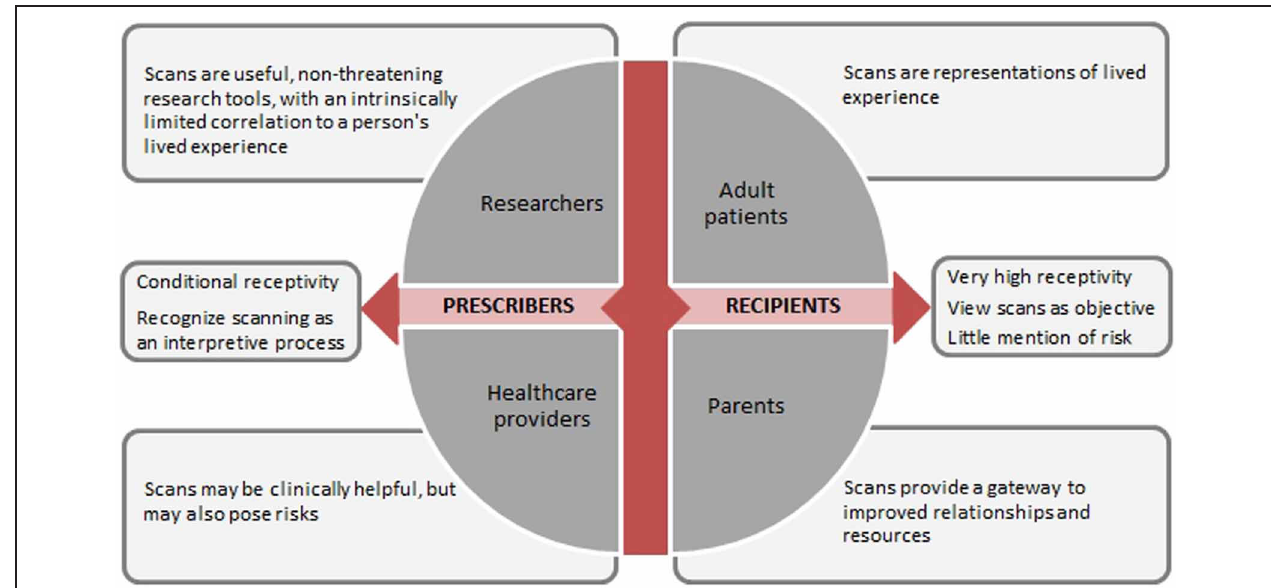
FIGURE 1 | Translational relationships to brain scan